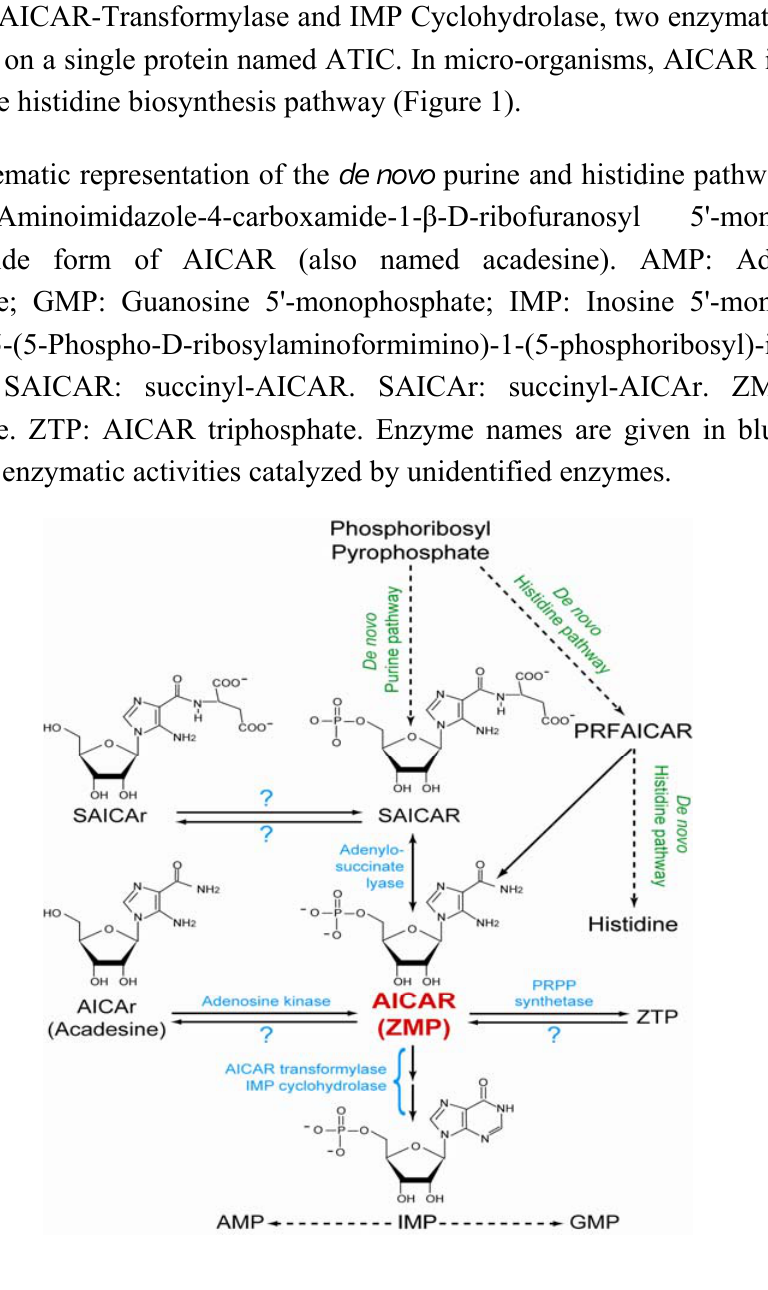
Figure 1. Schematic representation of the de novo purine and histidine pathways in yeast. 5-Aminoimidazole-4-carboxamide-1- β -D-ribofuranosyl